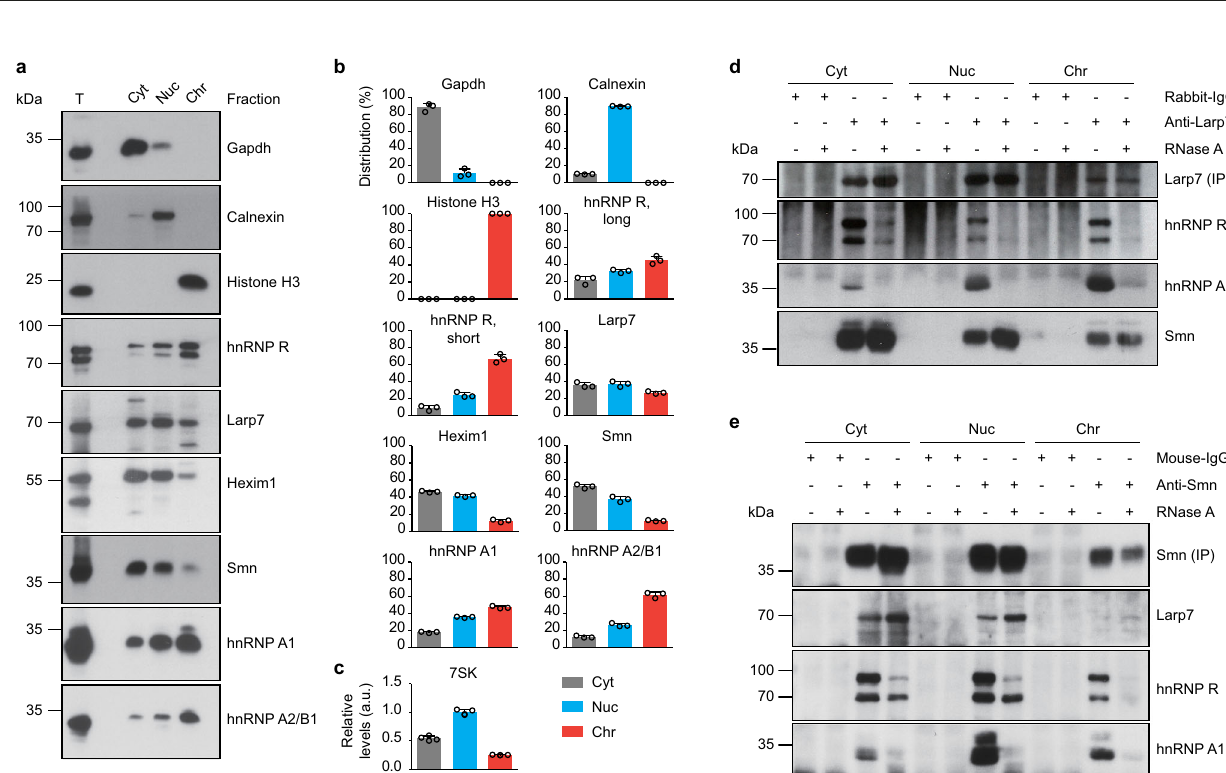
Fig. 3 Reduced snRNP production upon transcriptional inhibition. a Western blot analysis of Smn and Larp7 protein levels in NSC-34 cells treated with DMSO or ActD for the indicated durations. b Quanti fi cation of Larp7 protein levels in a . Data are mean ± s.d.; **** P ≤ 0.0001; n.s., not signi fi cant; two-way ANOVA with Sidak ’ s multiple-comparisons test ( n = 3). c Co-immunoprecipitation of Larp7 by anti-Smn from NSC-34 cells treated with DMSO or ActD for the indicated durations. d Quanti fi cation of Larp7 co-puri fi cation by anti-Smn in c . Data are mean ± s.d.; ** P ≤ 0.01; *** P ≤ 0.001; **** P ≤ 0.0001; n.s., not signi fi cant; two-way ANOVA with Sidak ’ s multiple-comparisons test ( n = 3). e Co-immunoprecipitation of Mepce by anti-Smn from NSC-34 cells treated with DMSO or ActD for 6 h. f Co-immunoprecipitation of Mepce and Smn by anti-SmB/B ’ from NSC-34 cells treated with DMSO or ActD for 6 h. Note that the immunosignal at 25 kDa for mouse-IgG immunoprecipitation is non-speci fi c from the antibody light chain. g qPCR analysis of total snRNA levels in NSC-34 cells treated with DMSO or ActD for the indicated durations. Data are mean ± s.d.; * P ≤ 0.05; ** P ≤ 0.01; *** P ≤ 0.001; **** P ≤ 0.0001; two-way ANOVA with Sidak ’ s multiple-comparisons test ( n = 3). h qPCR analysis of snRNAs co-precipitated by anti-SmB/B ’ from NSC-34 cells treated with DMSO or ActD for the indicated durations. Data are mean ± s.d.; * P ≤ 0.05; **** P ≤ 0.0001; two-way ANOVA with Sidak ’ s multiple-comparisons test ( n = 3). i Agarose gel electrophoresis of biotinylated U2 snRNA. j In vitro snRNP assembly assay. Biotinylated U2 snRNA was incubated with cytosolic extracts from NSC-34 cells exposed to DMSO or ActD for 6 h. Reactions were assembled with or without exogenous ATP. Biotinylated U2 snRNPs were pulled down with streptavidin beads and SmB/B ’ was analyzed by Western blot. k Quanti fi cation of in vitro U2 snRNP assembly assay in j . Data are mean ± s.d.; ** P ≤ 0.01; *** P ≤ 0.001; **** P ≤ 0.0001; two-way ANOVA with Tukey ’ s multiple-comparisons test ( n = 3). Source data are provided as a Source Data fi le.